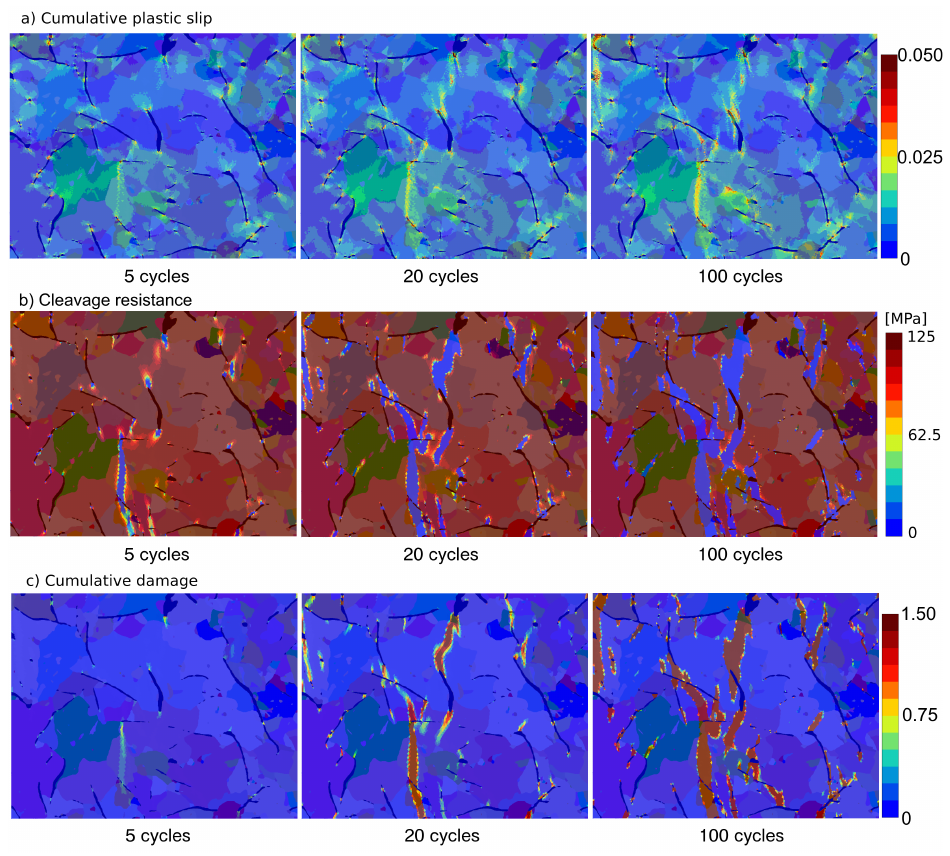
Figure 17. Cumulative plastic slip ( a ), cleavage resistance ( b ) and cumulative damage ( c ) after different number of